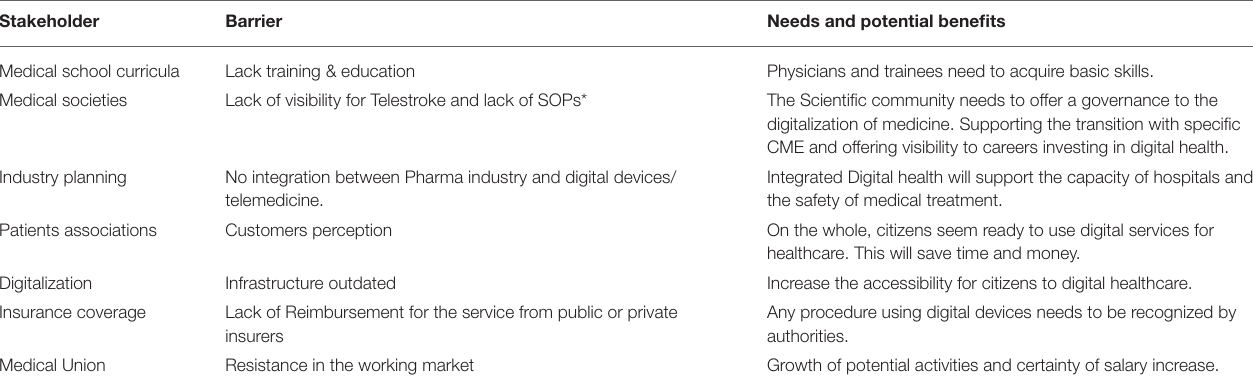
TABLE 1 | Telestroke: Stakeholder, barriers to the digital transition, potential countermeasures. Stakeholder